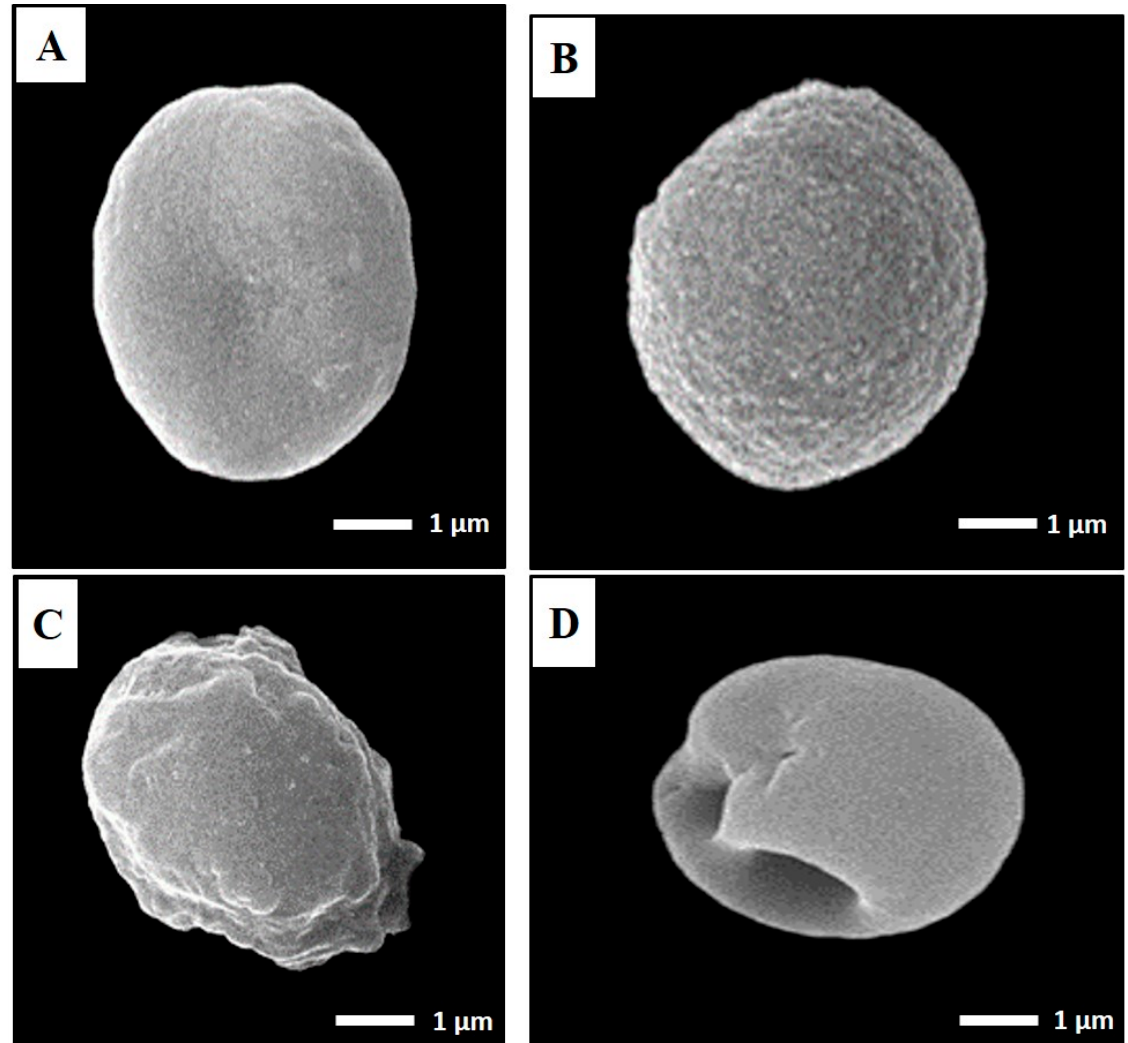
Figure 5. SEM ultrastructural morphological features of T. gondii cysts isolated from the infected control group ( A ), mice preimmunized with TLA ( B ), and mice preimmunized with TLA/RA-SLNs ( C , D ) (×10,000). ( A ) Regular spherical-shaped bodies. ( B ) Mild-to-moderate roughness and surface irregularities yet preserved spherical outline. ( C ) Marked surface irregularities with diffuse swelling. ( D ) Body indentations.